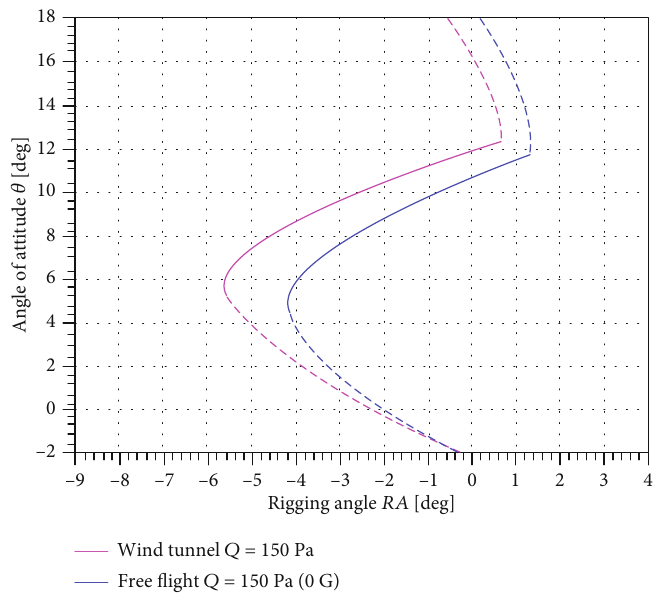
Figure 18: The analysis results of RA and parafoil attitude under high dynamic pressure and weightless